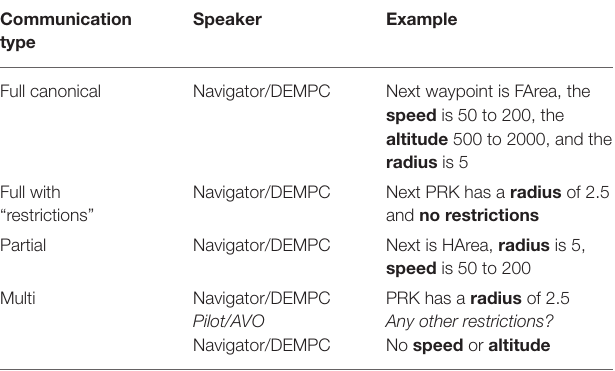
TABLE 3 | Summary of analyzed Navigator/DEMPC communication types. Communication